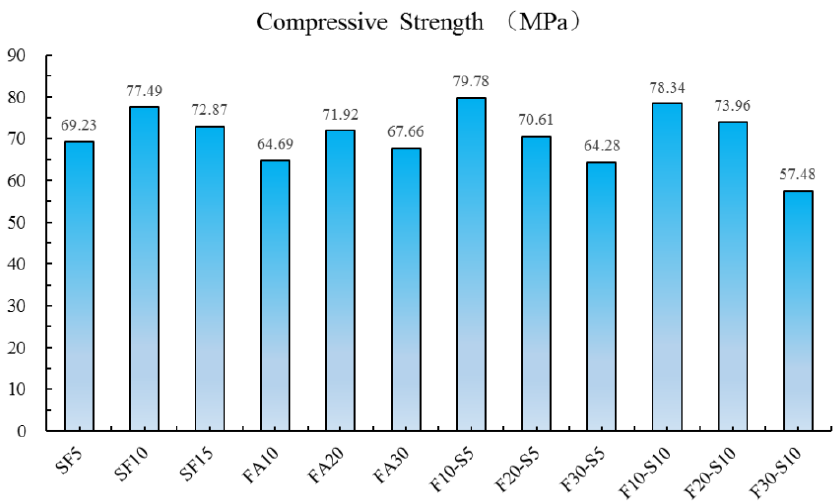
Figure 6. Compressive strength of the Group Ⅱ specimens.